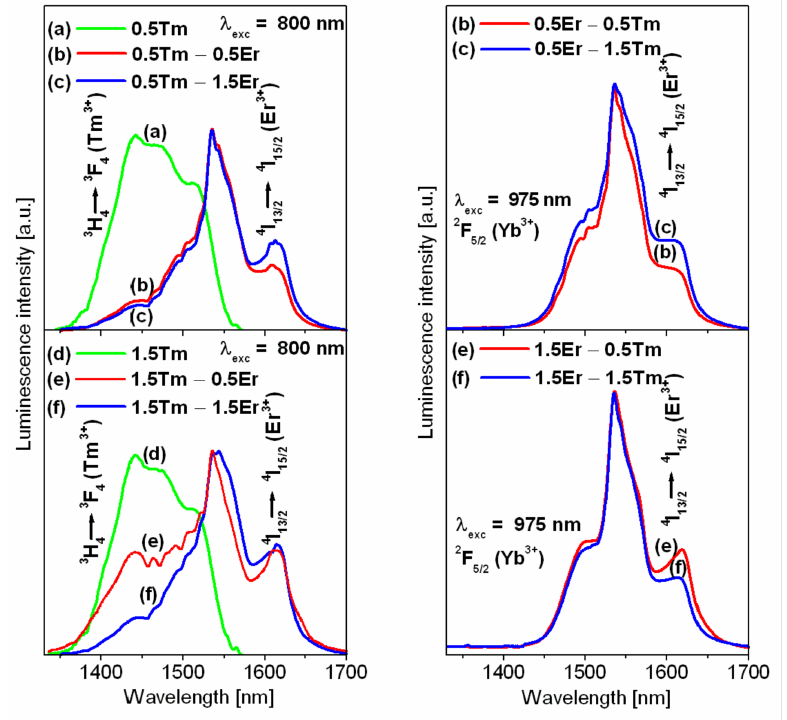
Figure 1. Normalized NIR luminescence spectra for lead germanate glass containing Yb 3+ /Er 3+ /Tm 3+ and Yb 3+ /Tm 3+ ions excited at 800 nm ( left ) and 975 nm ( right ). Spectra measured in the 1330–1700 nm range were normalized to compare their emis- sion profiles and bandwidth referred to as full width at half maximum (FWHM). For glass samples excited at 800 nm, the spectra showed emission bands centered at about 1450 nm and 1530 nm, which are assigned to the 3 H 4 → 3 F 4 (Tm 3+ ) and 4 I 13/2 → 4 I 15/2 (Er 3+ ) tran- sitions of lanthanides. Owing to some excellent papers published previously [43–46], the shoulder near 1650 nm in sample 1.5 Tm–0.5 Er belongs to the short-wavelength tail of the emission due to the 3 F 4 → 3 H 6 transition of Tm 3+ . The relative integrated intensities of NIR emission bands depend on Er 3+ and Tm 3+ concentrations. In particular, the changes in emission profiles and bandwidths are clearly visible for glass samples with higher Tm 3+ (1.5 mol%) concentration. In contrast to glass samples with low (0.5 mol%) concentration, the intensity of the NIR emission band due to the 3 H 4 → 3 F 4 transition of Tm 3+